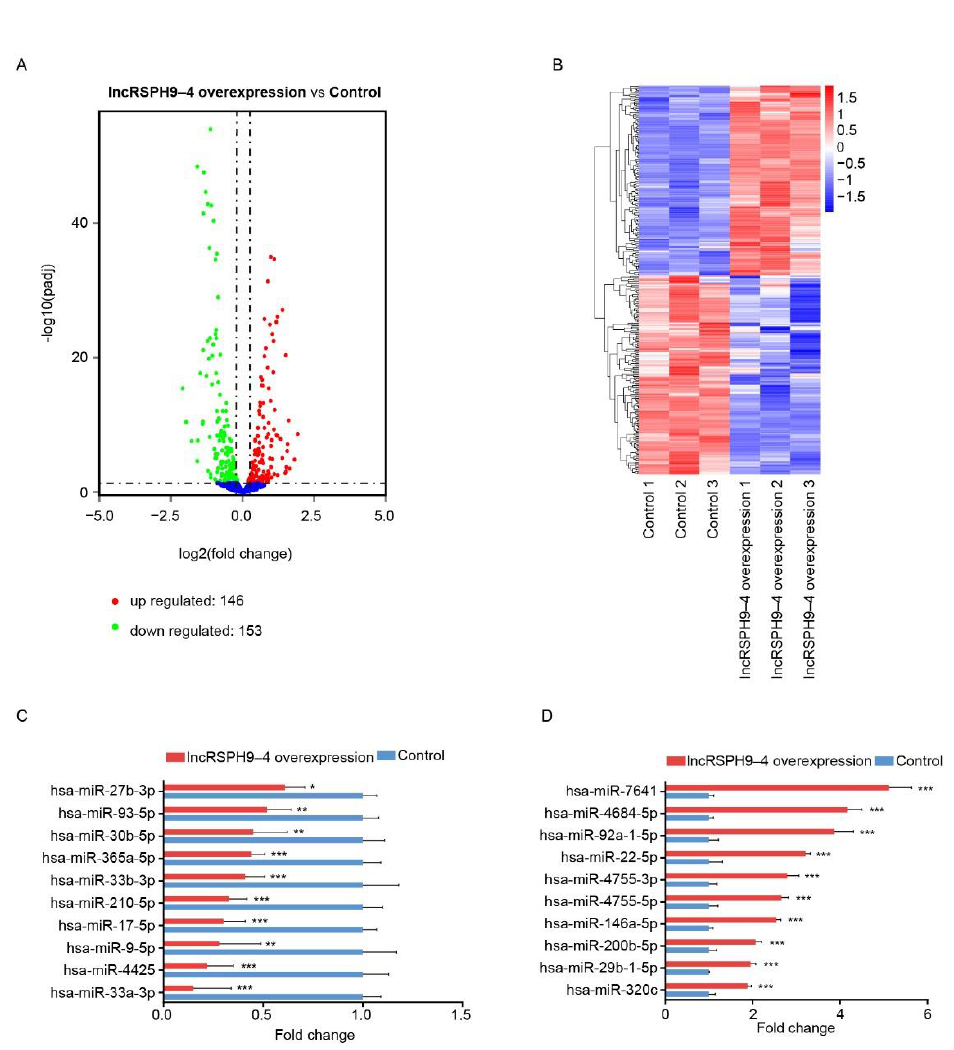
Figure 4. The miRNA transcription profiles in lncRSPH9-4 overexpressed hBMECs. ( A ) Volcano plot exhibiting the differentially expressed miRNAs in hBMECs in response to lncRSPH9-4 overexpression. The red and green plots represent the significantly up-regulated and down-regulated miRNAs, respectively. ( B ) Heatmap showing the unsupervised clustering of significantly changed miRNAs in hBMECs with or without lncRSPH9-4 overexpression. ( C , D ) qPCR validation of the down-regulated or up-regulated miRNAs in hBMECs with the overexpression of lncRSPH9-4. U6 was used as the reference control. * p < 0.05, ** p < 0.01 and *** p < 0.001.